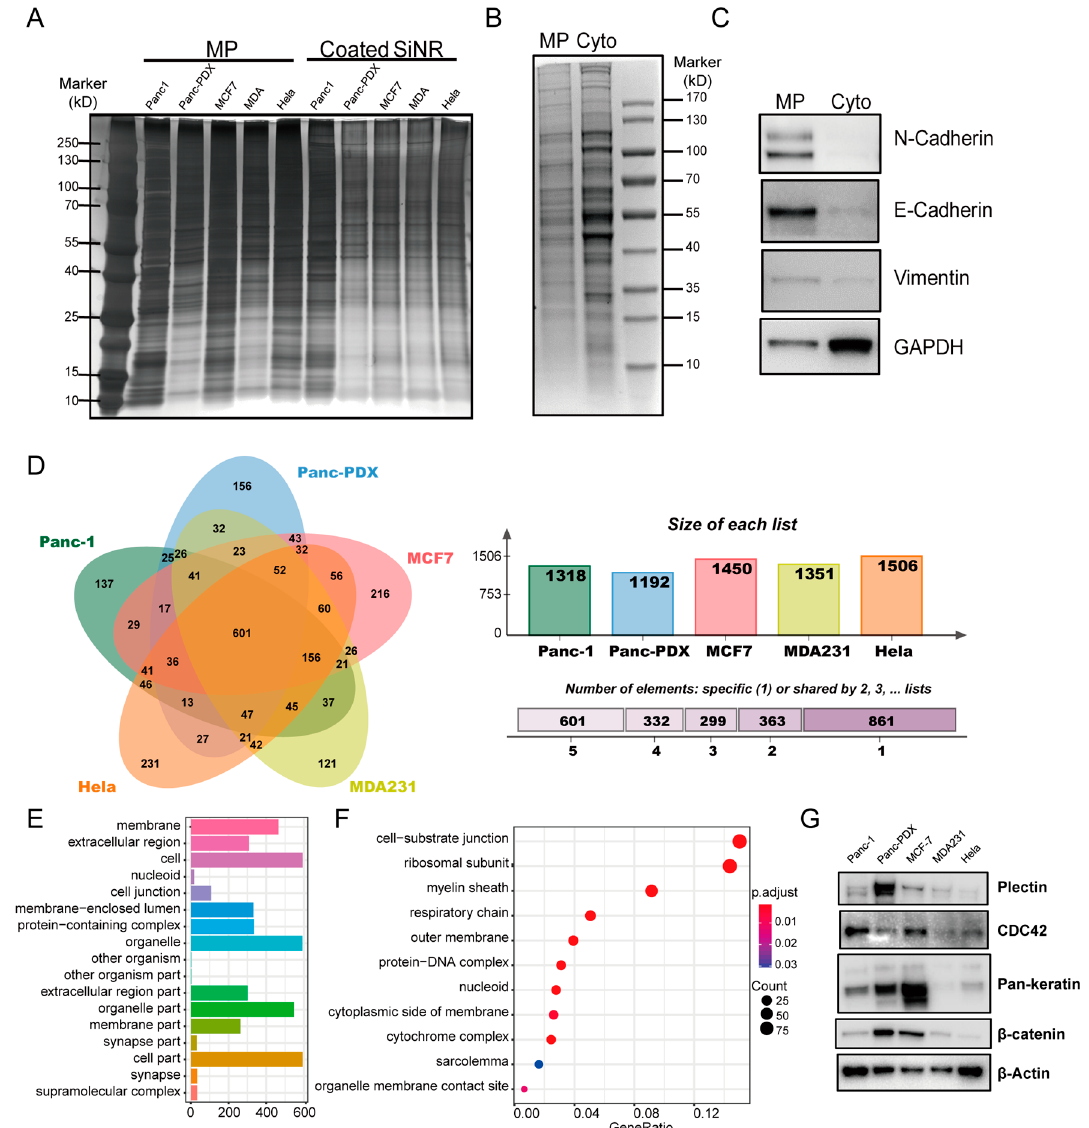
Figure 3. Proteomics analysis of five cell membrane extracts. ( A ) Silver staining of membrane protein lysate and CMP-coated SiNR PAGE with 20 µ L protein loading. Panc-1 cell membrane extraction and cytoplasmic extraction were confirmed by silver staining ( B ) and western blot ( C ). N-cadherin and E-cadherin are cell junction markers, vimentin is a cytoskeleton protein, GAPDH is a metabolic enzyme located in the cytoplasm. ( D ) Venn plot of the proteins identified from the five types of cell membrane extracts. The center part of the plot stands for the 601 common proteins in all five cell types. The outer single-color parts are unique proteins which belong to each single type cell. The top right panel shows the total protein number of each cell type. The buttons in the right panel are different shared proteins among the five types of cell membrane extracts. ( E ) The cellular component group has 601 common proteins; 50% of the proteins are associated with the extracellular region and 16.7% proteins belong to the cell junction gene set. ( F ) GO enrichment result of the 601 common proteins. The focal adhesion term is enriched with a significant p -value < 1 × 10 − 9 . ( G ) Selected protein targets from the common 601 proteins in the five cell types: Plectin, CDC42, β -catenin, and β‐ actin. We analyzed Panc ‐ 1 to validate that the protein extraction was indeed from the cell membrane. N ‐ cadherin and E ‐ cadherin are proteins that anchor the plasma membrane and act as cell junction markers [53] and they were highly expressed in the Panc ‐ 1 membrane extract (Figure 3B and C). Vimentin is a cytoskeleton protein that acts as an intermediate filament. It was present on both the membrane extract and the cytoplasmic lysate. Protein gel sets derived from the above setting were